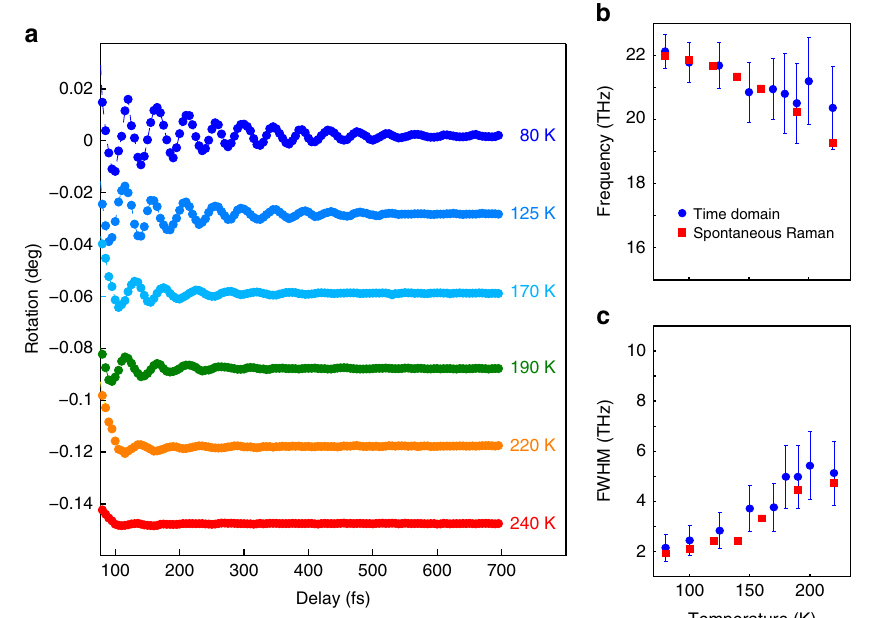
Figure 3 | Temperature dependence of the ultrafast spin dynamics. ( a ) Rotation of the probe polarization as a function of the temperature. The pump and the probe beams are linearly polarized along the z and y axes, respectively. The fluence is E 8.6mJcm (cid:2) 2 . ( b , c ) The temperature dependence of the frequency and linewidth of the 2M Raman peak (red squares) compared with the trends obtained by applying the Fourier transform to the time-domain data (blue circles). The error bars in b and c for the time-domain data are defined as the half width at half maximum of the 2M frequency distribution. The error bars for the Raman data are defined by the instrumental sensitivity ( E 2cm (cid:2) 1 ) and are not visible in this